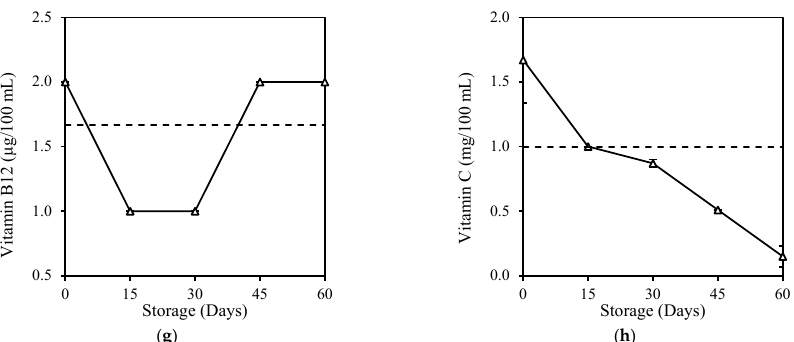
Figure 3. Changes in ( a ) Vitamin A, ( b ) Vitamin B3, ( c ) Vitamin B5, ( d ) Vitamin B6, ( e ) Vitamin B7, ( f ) Vitamin B9, ( g ) Vitamin B12, and ( h ) Vitamin C of HPP and ESL milk during 60-day storage. Dotted lines represent the fresh milk before treatment.